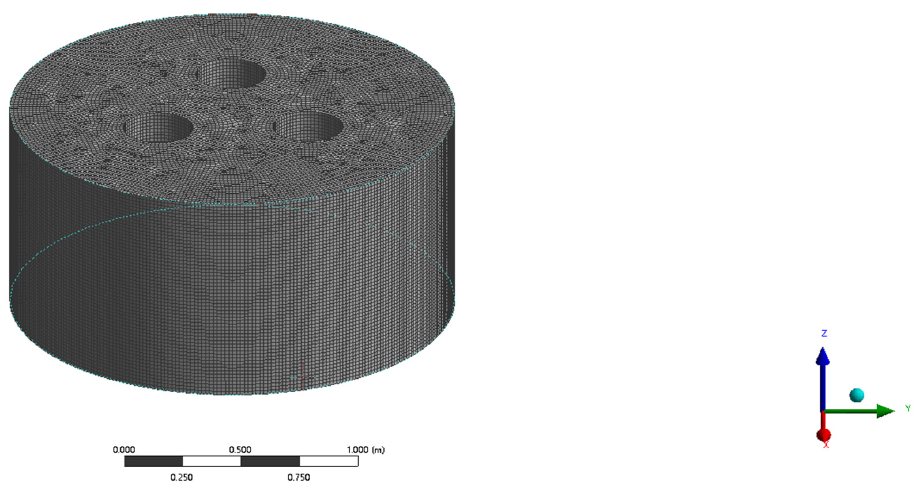
Figure 3. Mesh distribution.